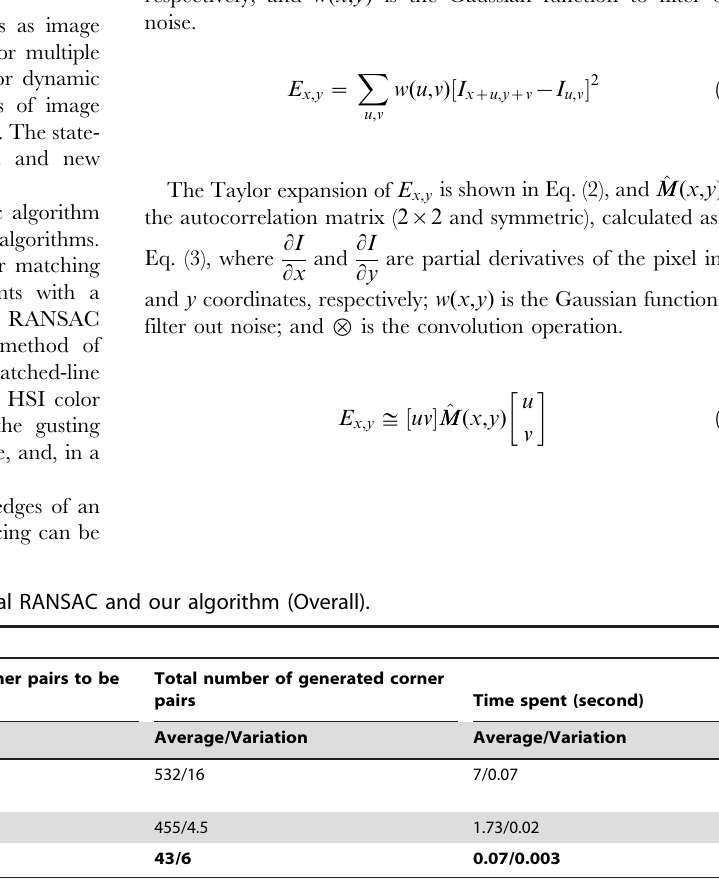
Total number of corner pairs to be processed